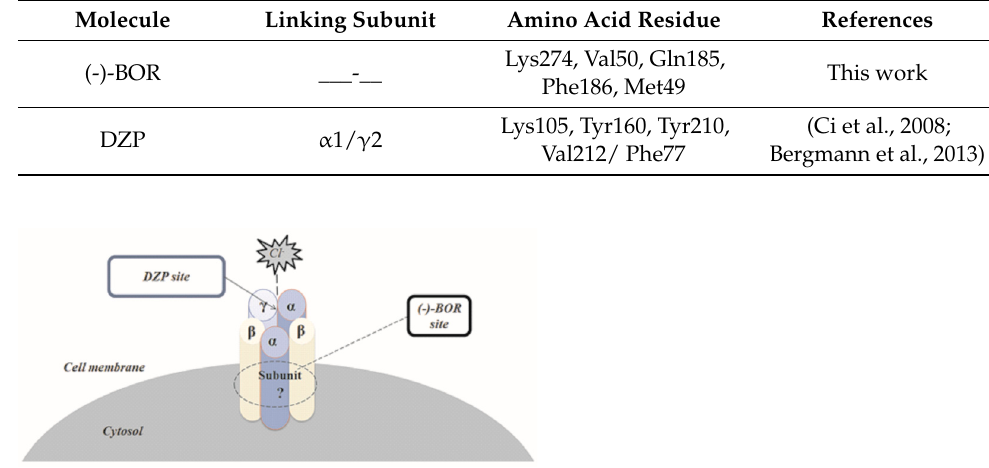
Figure 8. Illustration of the DZP binding site and the possible extracellular region in which the monoterpene (–)-BOR binds to GABA A R.